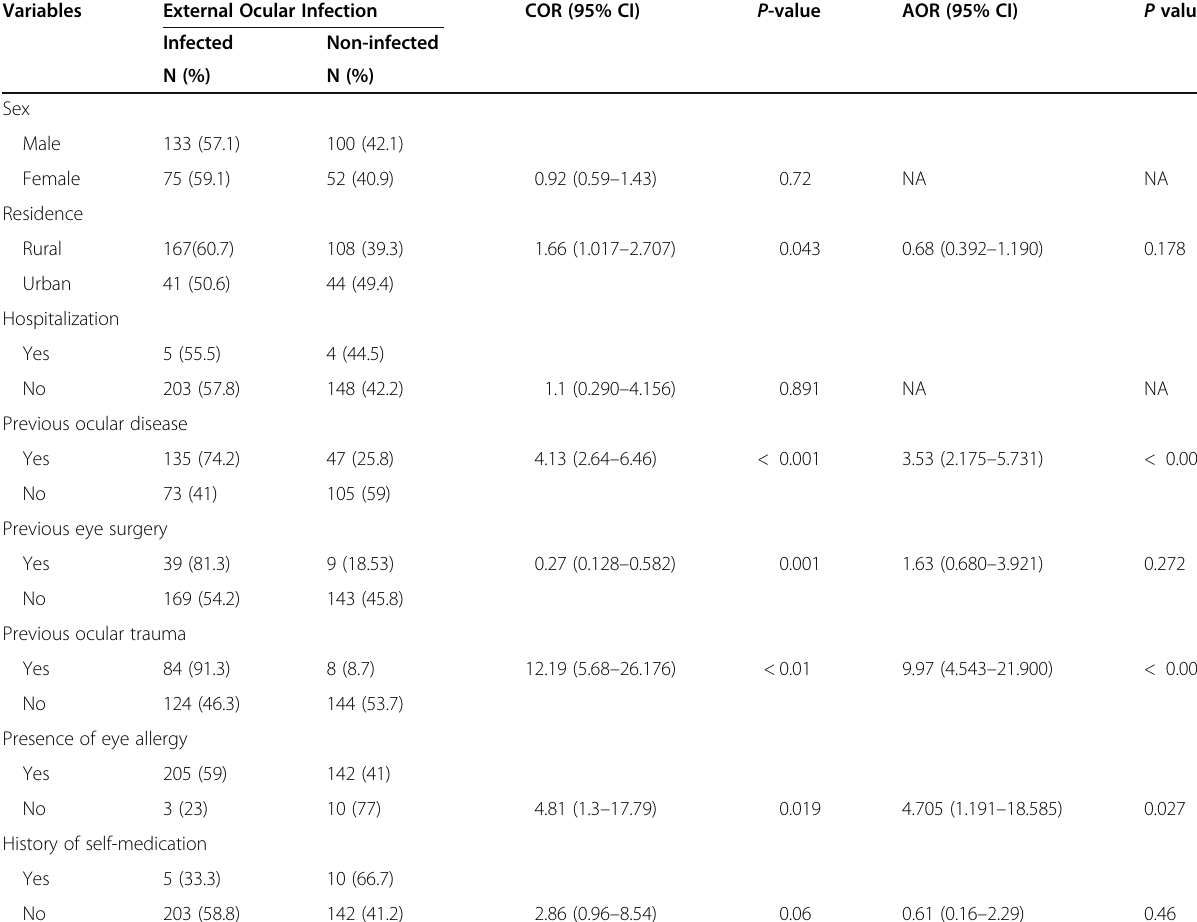
Key: COR Crude Odds Ratio, AOR Adjusted Odds Ratio, CI Confidence interval, NA Not